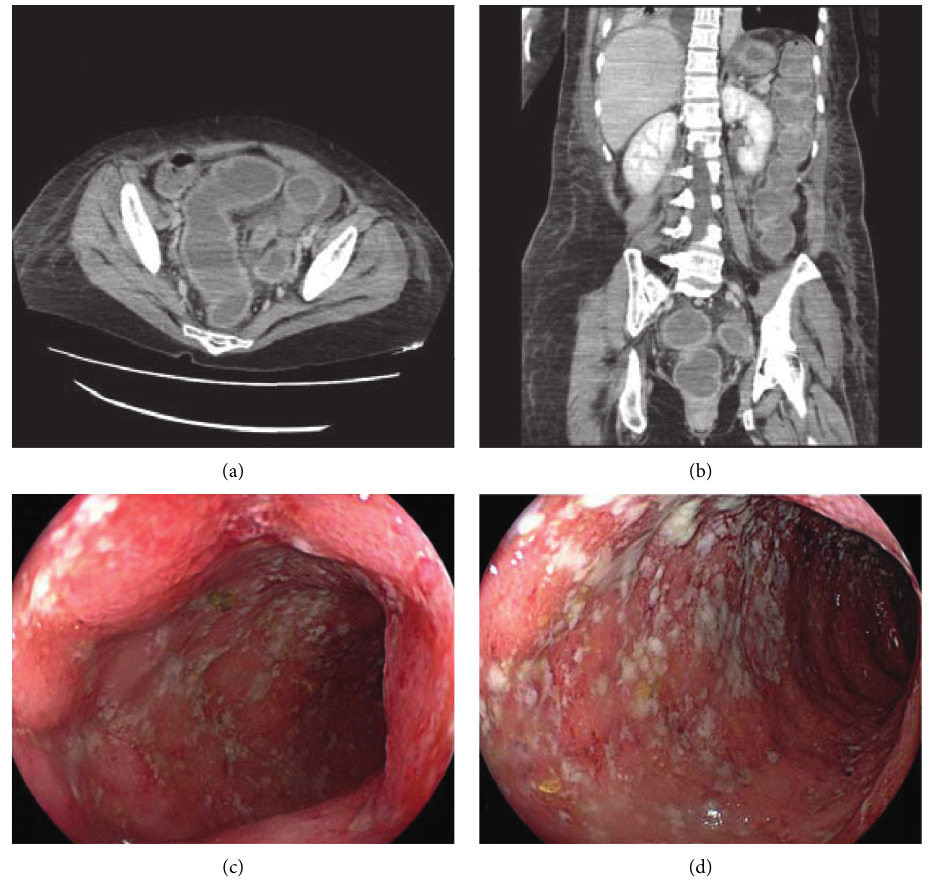
Figure 2: (a) Axial and (b) coronal images of contrast enhanced computed tomography (CT) showing colonic mural thickening and enhancement of the left-sided colon, consistent with colitis. Hyperattenuating material within the bowel lumen can be seen, suggestive of blood clots. Endoscopic findings of the (c) rectum and (d) sigmoid colon showing edematous mucosa with marked erythema, absent vascular pattern, friability, and erosions, which are consistent with ulcerative colitis (UC).